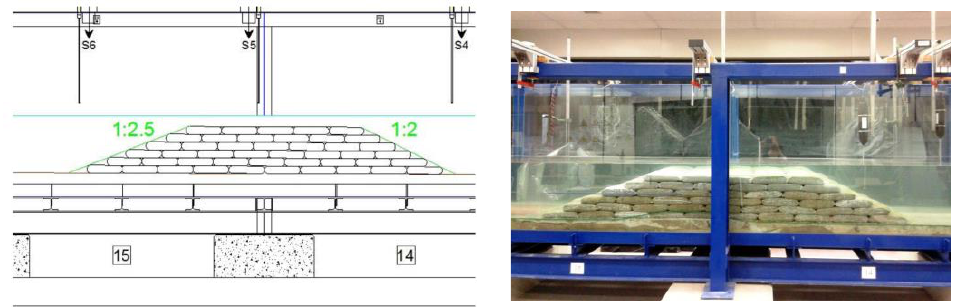
Figure 8. Sketch and physical model of the submerged barrier with 6 layers of GSCs and a submergence R c = − 0.087 m. Table 3. Regular and random wave characteristics for submerged breakwaters.